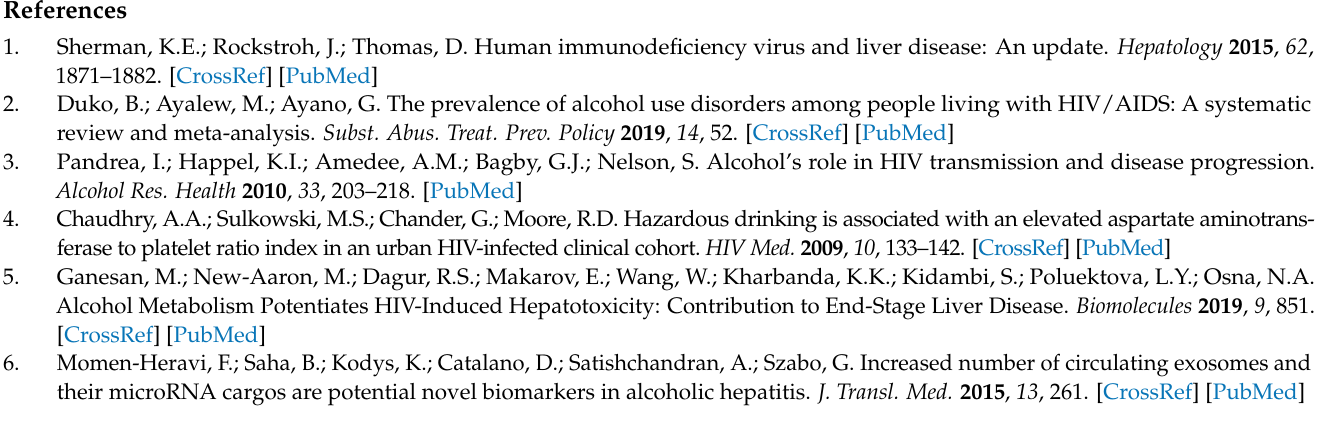
EVs, Figure S2: Scheme showing the process of EV isolation, and further purification for human- Figure S4: The ratio of EVs and protein concentration isolated from different treatment groups. Figure S5: Apoptosis in RLW XP-GFP cells treated with HIV and EtOH is prevented by pan-caspase inhibitor and restore EVs comparable to control. Figure S6: AGS-HIV treatment neutralizes the lysosomal acidification in RLW XP-GFP cells. Figure S7: Alanine aminotransferase (ALT) levels in the serum of FRG-KO liver-humanized mice were not affected when fed with EtOH in the absence or presence of HIV